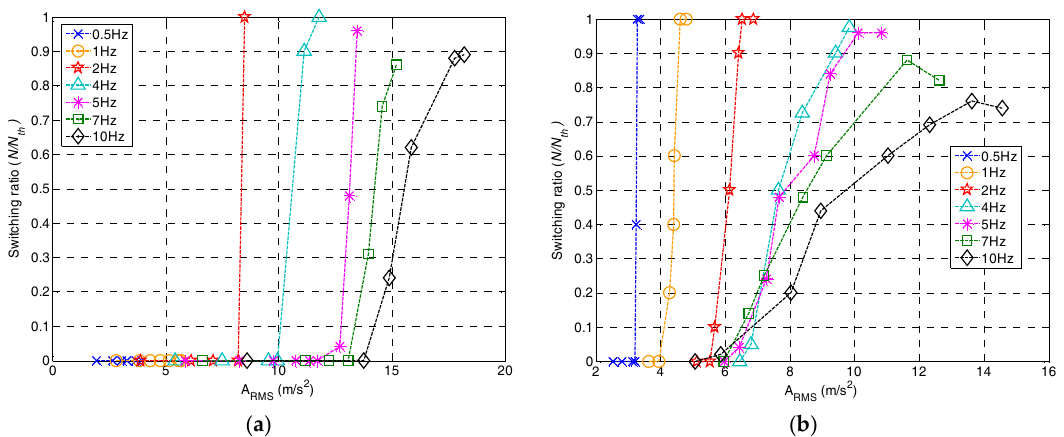
Figure 2. The normalized number ( N / N th) of switches vs. the root mean square (RMS) acceleration, Acc RMS , for the frequency range 0.5–10 Hz in cases ( a ) without and ( b ) with the repulsive magnet.